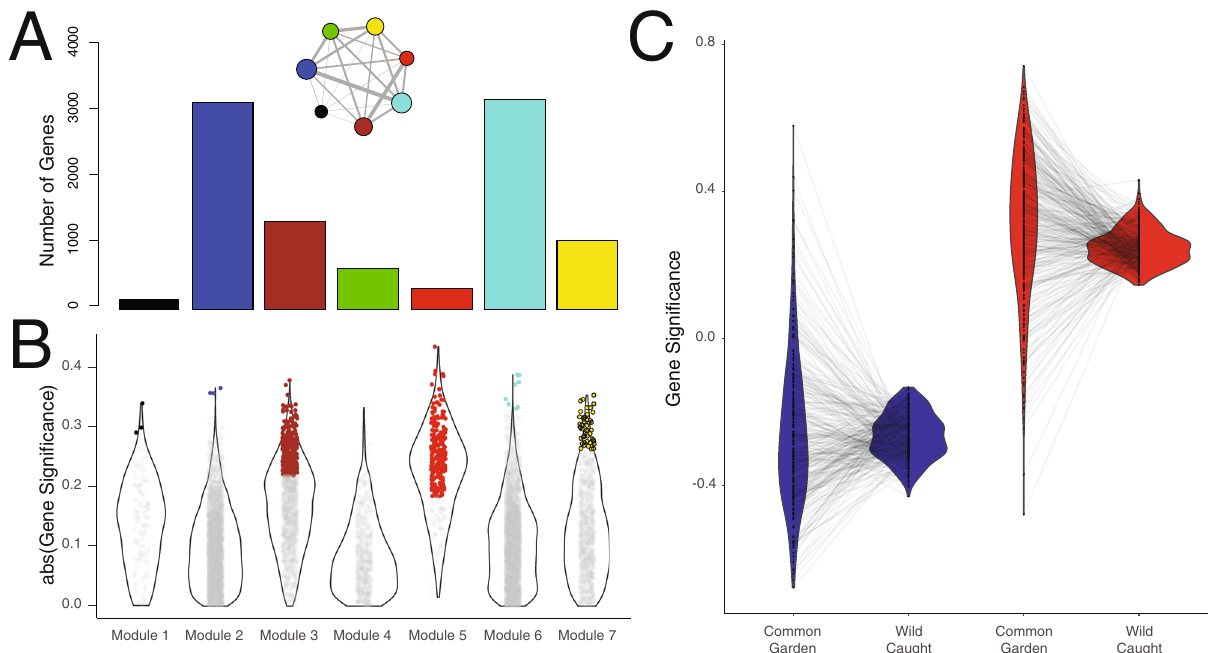
Fig. 3 Identi fi cation of genes associated with heat tolerance in common garden and wild-caught lizards. A One hundred and thirty lizards from heterogeneous treatments (114 wild-caught, 16 common garden) were used to identify co-expression modules of the Anolis skeletal muscle transcriptome. Weighted gene correlation network analysis (WGCNA) revealed seven regulatory modules that de fi ne the full regulatory architecture of the skeletal muscle transcriptome: Module 1 (black), Module 2 (blue), Module 3 (brown), Module 4 (green), Module 5 (red), Module 6 (turquoise), and Module 8 (yellow) 60 . Bars represent the number of genes within each module. Inset is a representation of connectivity among co-expression modules. Circle sizes represent the relative size of each module (circle area is proportional to log-transformed number of genes within each module) and line thickness represents the relative strength of connectivity between modules (absolute value of pairwise Pearson ’ s correlation among eigengene values). B Violin plot of gene signi fi cance scores (GS) for CT MAX (strength of association between gene expression and CT MAX ). Dots indicate individual genes assigned to each module. Colored dots within each module indicate genes with signi fi cant phenotypic correlations after multiple testing correction ( GS.q < 0.05). This subset of genes made up the focal data set of the current study. C To validate the candidate gene set, two additional network analyses were conducted for wild- caught ( n = 114) and common garden lizards ( n = 16), separately. Gene signi fi cance (GS) scores were calculated for candidate genes independently for each group. Genes identi fi ed as negatively correlated with CT MAX (negative regulators) in the full data set are indicated in blue; genes positively correlated with CT MAX in the full data set (positive regulators) are indicated in red. Black dots in the center of each violin plot are GS scores for each individual gene. Gray lines present the directionality of GS score change for each gene between common garden and wild-caught animals. There was a signi fi cant expression-phenotype correlation between wild-caught and common garden data (linear model, R 2 : 0.601; p « 0.001). Relative rank of gene signi fi cance was highly conserved across sets (Spearman ’ s rank correlation ρ : 0.75, p « 0.001). Negative regulators displayed no bias in gene signi fi cance between groups (paired t -test, p = 0.26). Positive regulators displayed higher gene signi fi cance values in the common garden data set than the wild-caught data set (paired t -test, p « 0.001). The gene – gene correlations between the wild-caught and common garden data sets was small but statistically signi fi cant in each case (positive regulators: R 2 : 0.04, p < 0.0001; negative regulators R 2 : 0.03, p = suite of genes involved in DNA replication and repair, which are critical for maintenance of DNA integrity during and after cellular heat shock 68 . These genes include several that encode kinesin, condensin, kinetochore, RNA helicase, and type II DNA topoisomerase proteins (Supplementary Table 2). Together, these functional associations highlight potential cellular mechanisms underpinning individual variation in heat tolerance and potential targets of selection within urban heat islands. We combined all individuals from common garden and wild- caught groups for initial candidate gene identi fi cation, in order to recover the most robust set of thermal tolerance-associated candidate genes in the species. Consequently, our candidate gene set captures expression-phenotype correlations due to the combined effects of developmental thermal environment (developmental plasticity), temperature-dependent expression in adult individuals (phenotypic fl exibility), and interactions therein. Capturing this variation in potential regulatory contributions was deemed critical for subsequent analyses, as selection on any of these components may play an important role in adaptive temperature-dependent gene expression divergence between lineages.